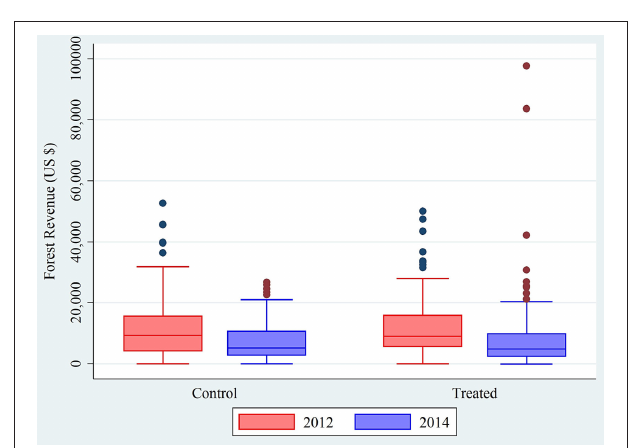
FIGURE 4 | Box plot for forest revenue—Madre de Dios site.